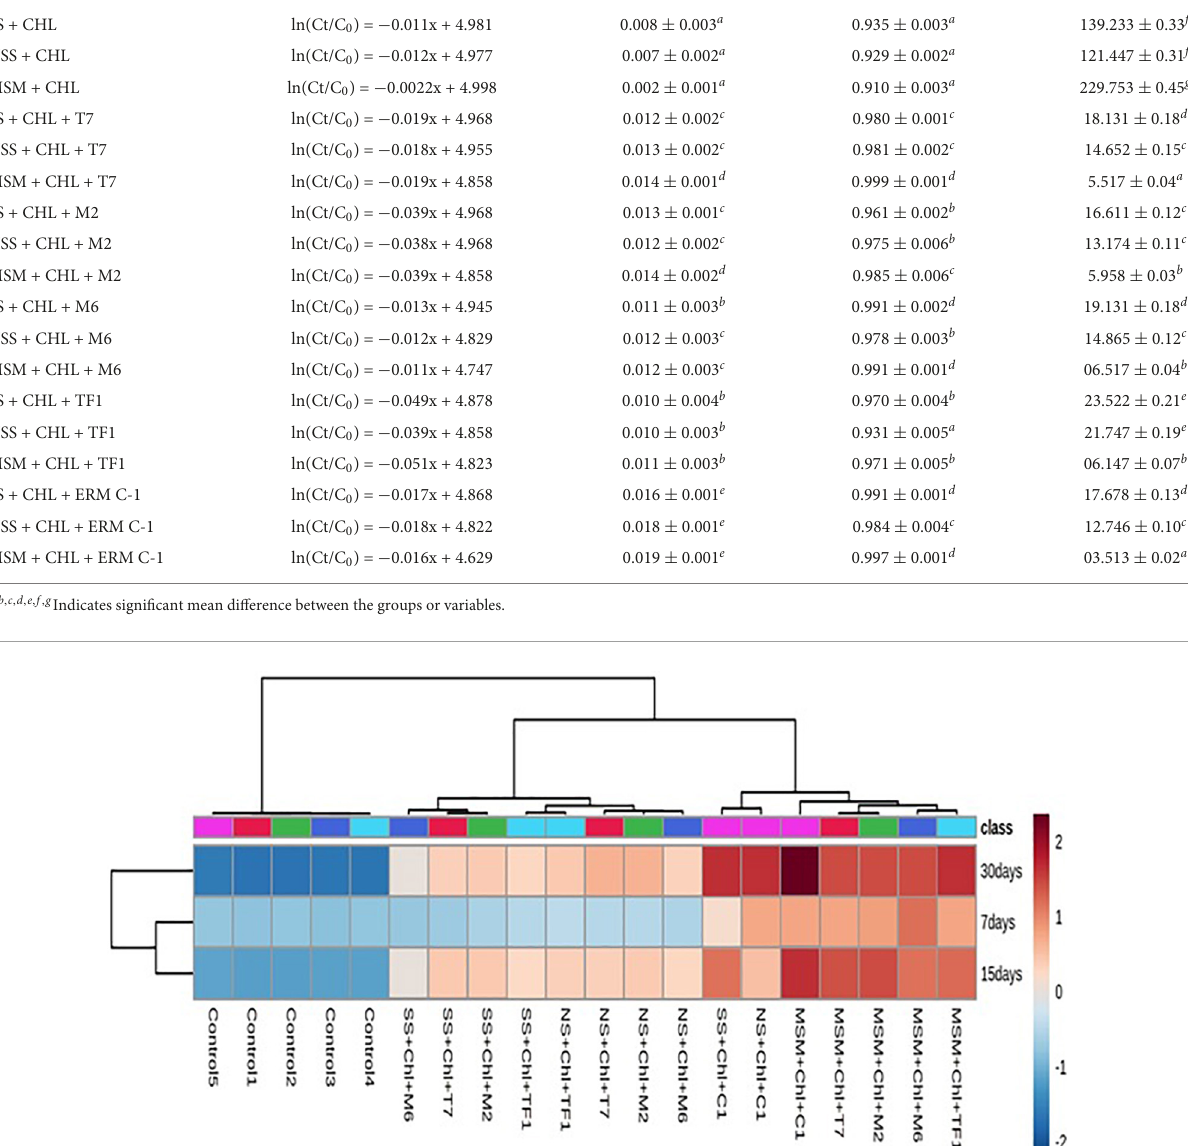
TABLE 2 Chlorpyrifos degradation kinetics and half-life ( t 1 / 2 ) in natural (NSS), sterile soil (SS), and mineral salt medium (MSM). Treatments